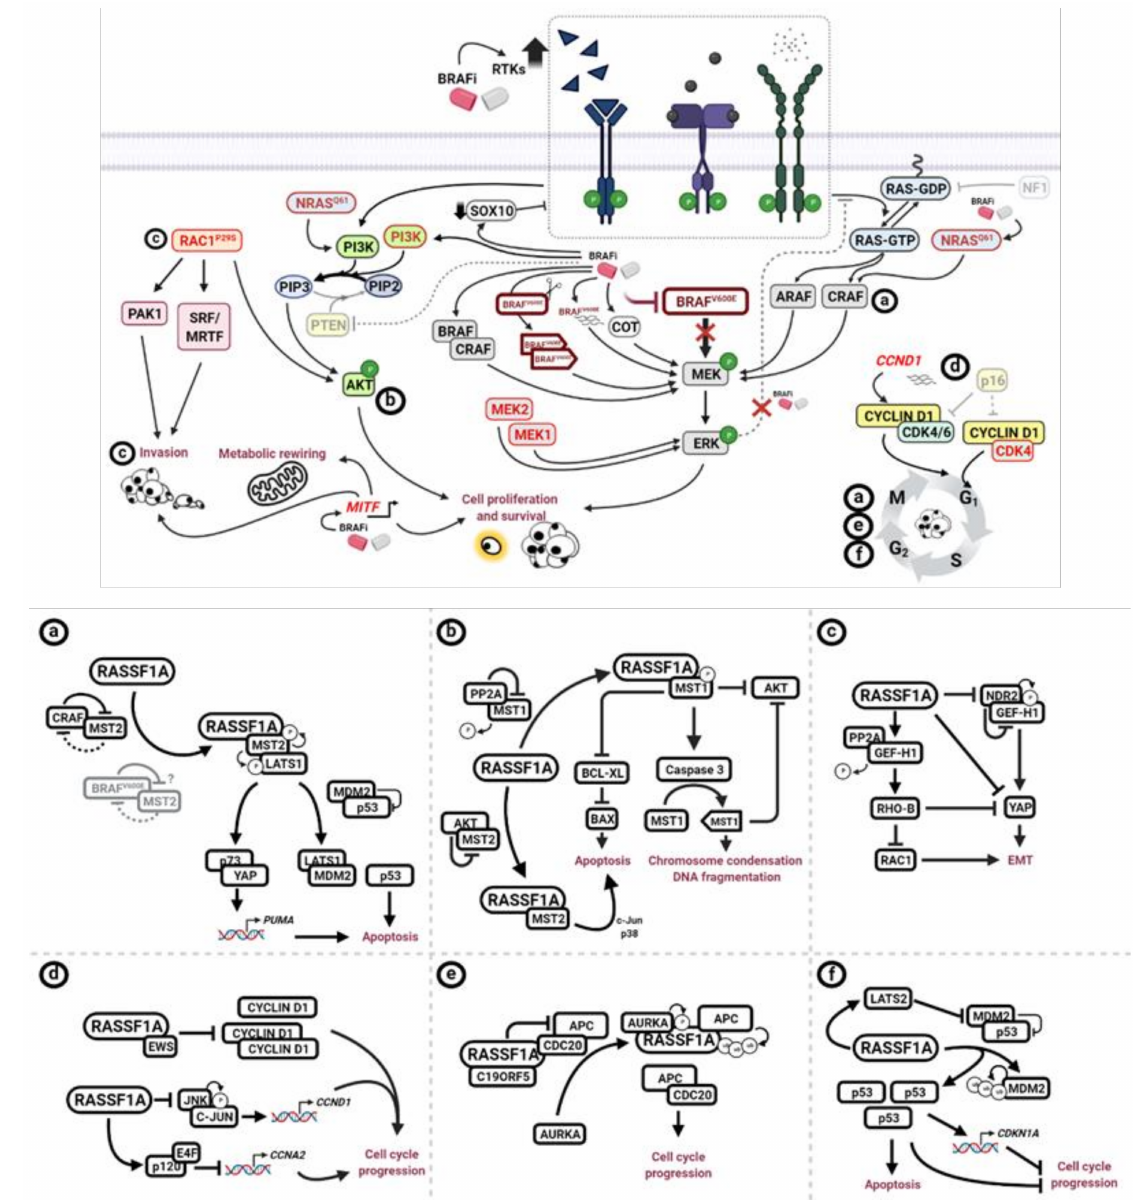
Figure 2. Schematic representation of the molecular mechanisms conferring resistance to BRAFi-targeted therapy (upper panel) and RASSF1A-mediated regulation of associated signalling processes (lower panel). Letters a to f in the upper panel represent the potential impact of RASSF1A on counteracting BRAFi resistance mechanism. Subfigures a to f from lower panel show the different biochemical mechanism regulated by RASSF1A referred to in the upper panel. (Created with